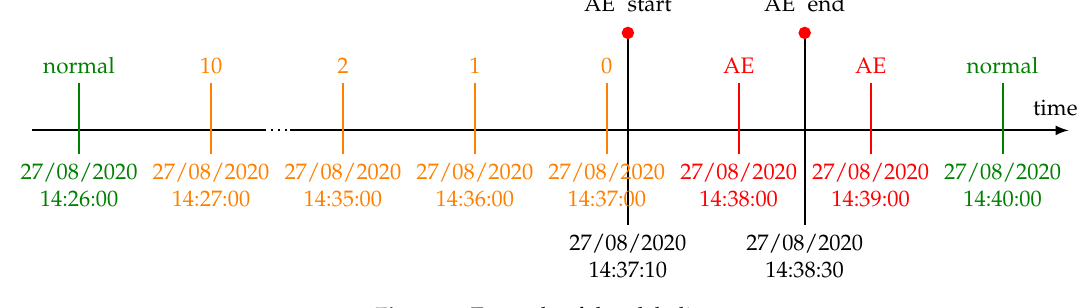
Figure 5. Example of data